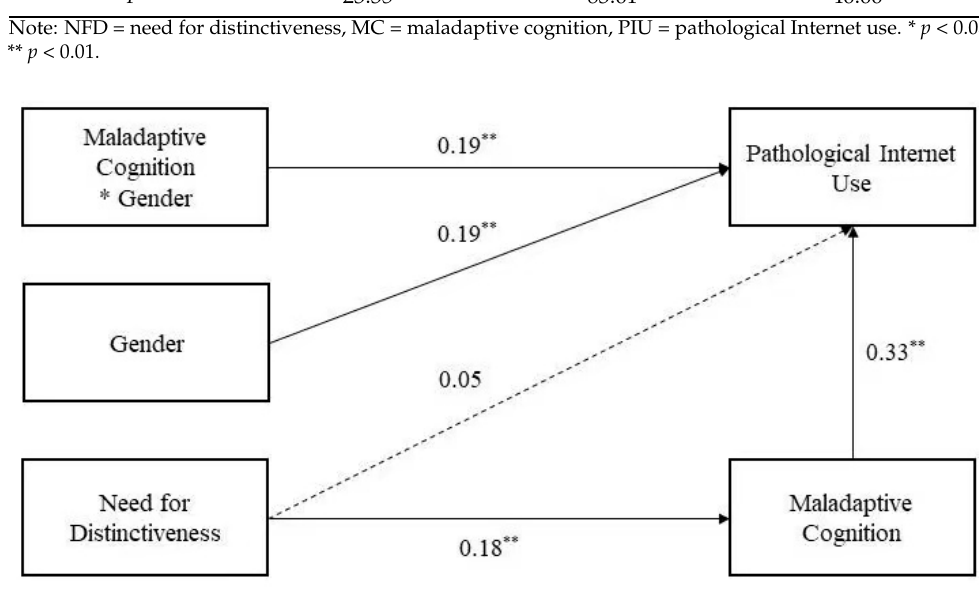
Figure 2. The confirmed structural model. * p < 0.05; ** p < 0.01